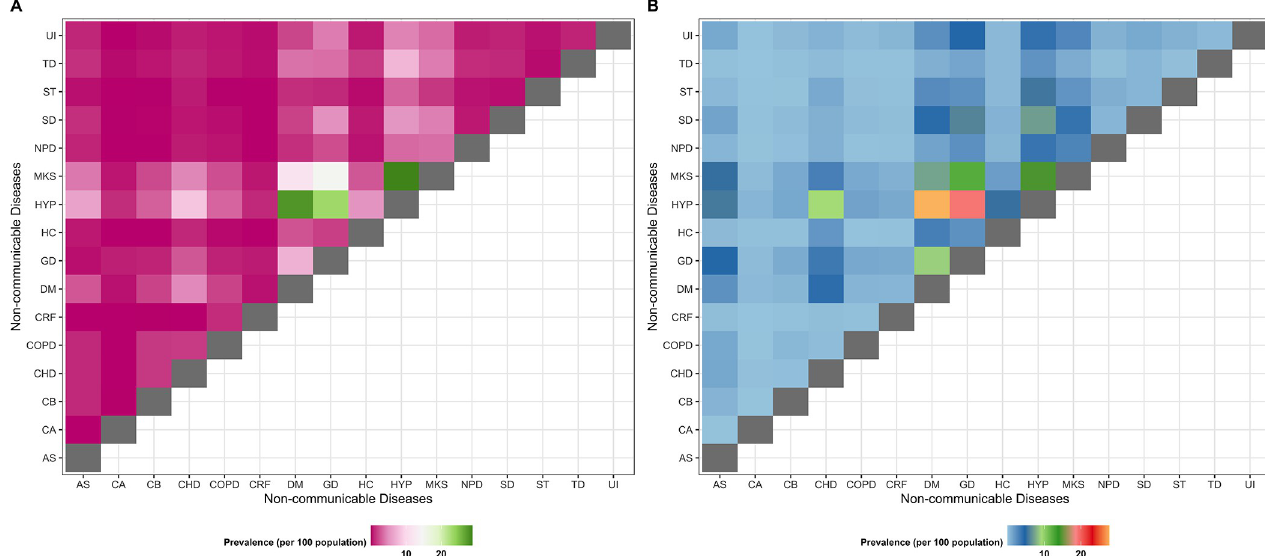
Fig 2. Heat maps depicting non-communicable disease dyads prevalence for (A) women and (B) men aged 45 years and above, Longitudinal Ageing Study in India (LASI), 2017–18.